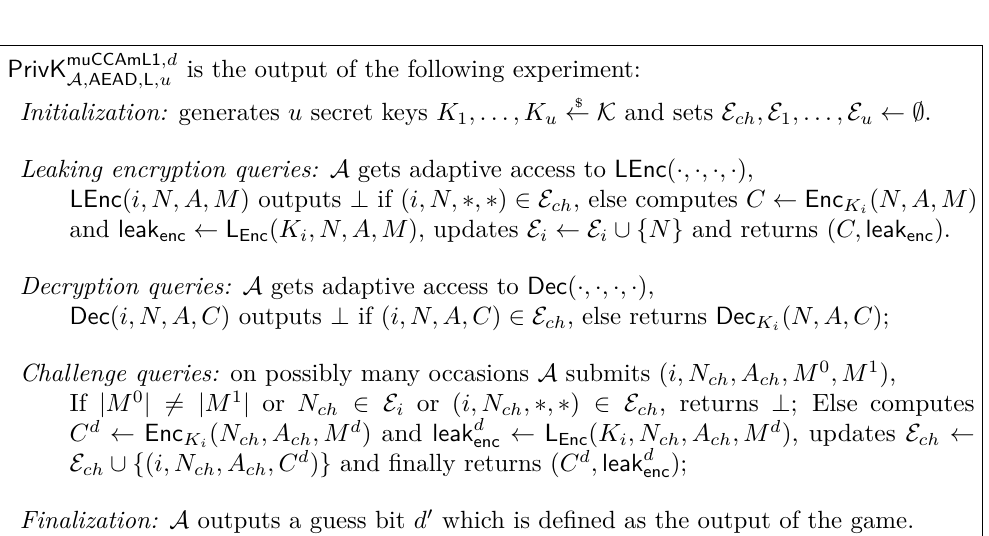
Figure 1: The PrivK muCCAmL1 ,d A , AEAD , L ,u